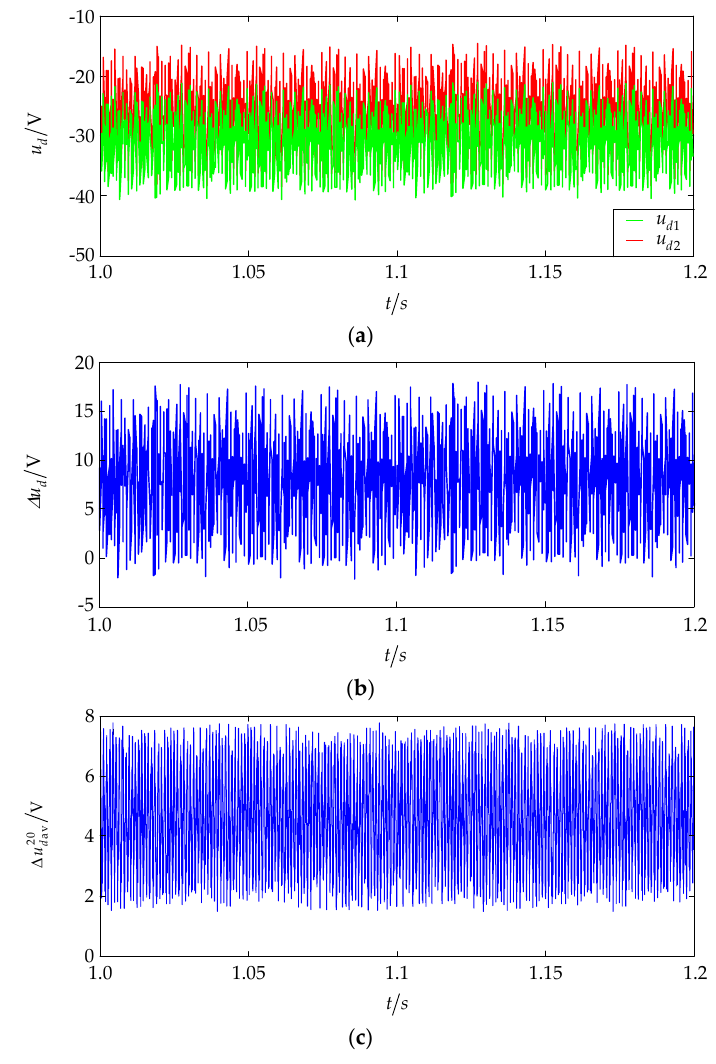
Figure 21. The waveforms about the d -axis voltage under faulty conditions: ( a ) The d -axis voltages of two sets of windings; ( b ) ∆ u d ; ( c ) ∆ u 20 d av